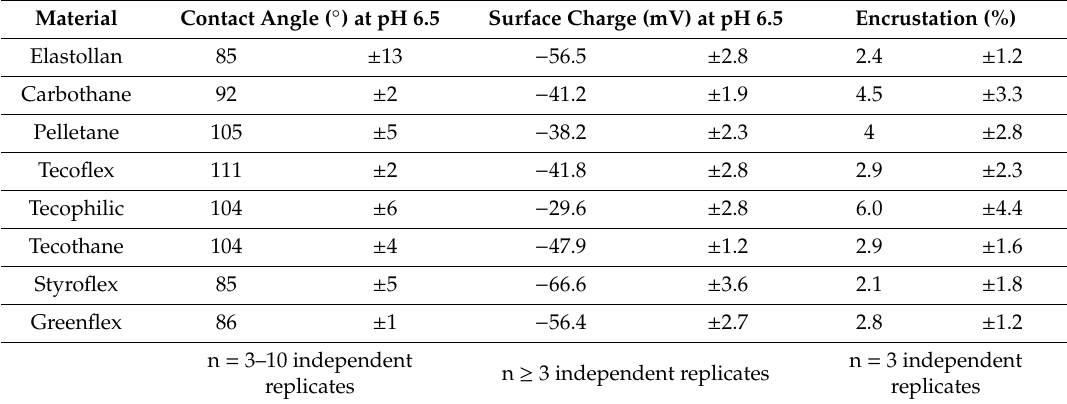
Table 2. Material characteristics of di ff erent polymer types. The quantity of encrustation can be correlated with the negative zeta potential and slight hydrophilicity of the polymer. Fields marked green indicate the lowest values for each parameter. Mean ± SD.